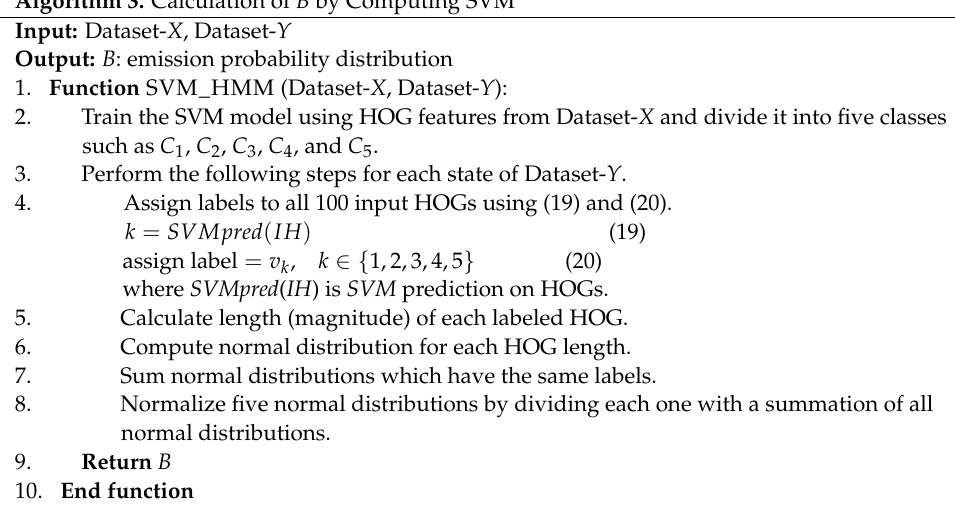
Algorithm 3. Calculation of B by Computing SVM